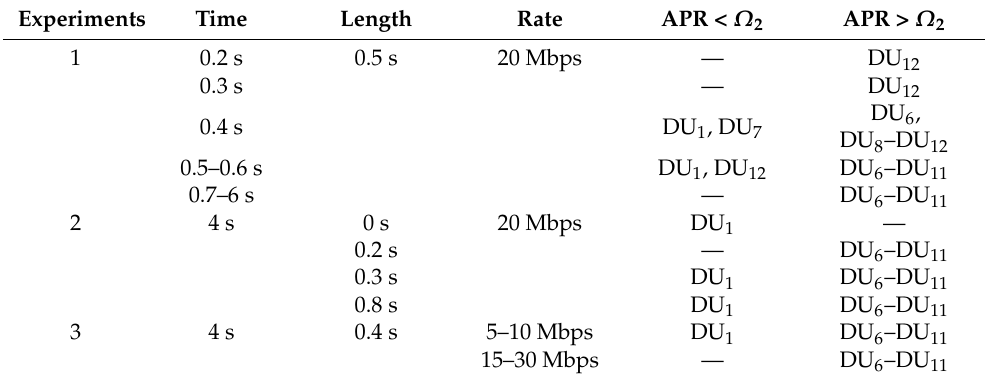
Table 3. Result on the base of pieces of TCP traffic